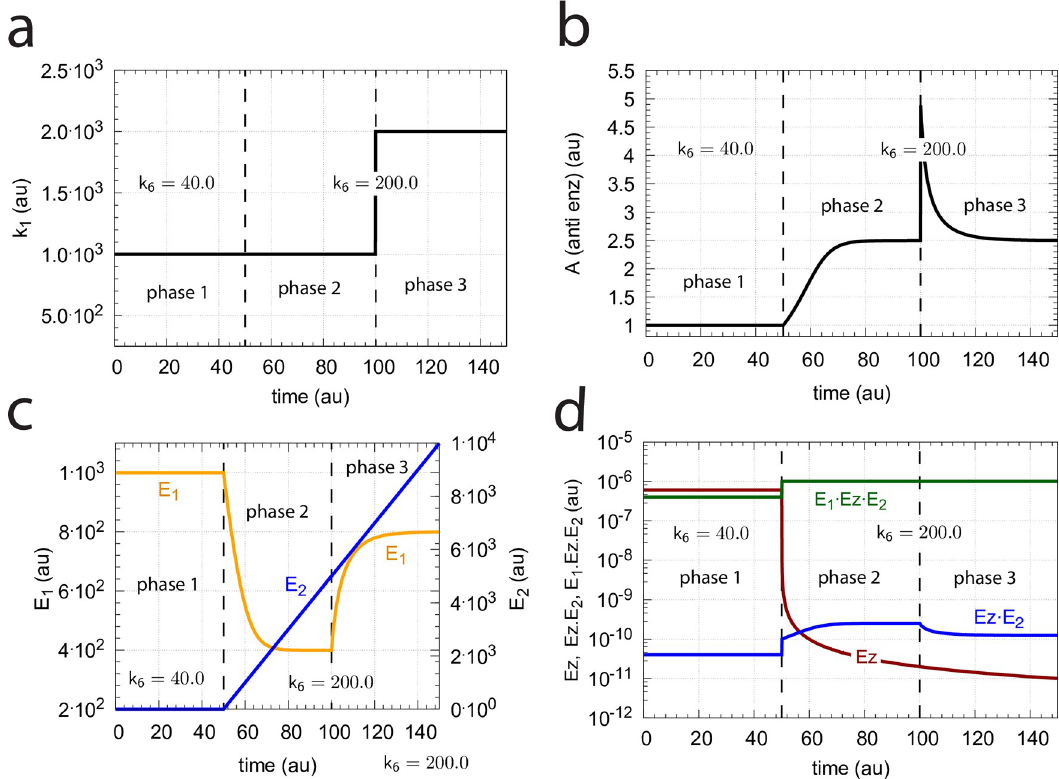
Fig 41. Switch from dual-E to single-E control by increase of k 6 in the compulsory ternary-complex mechanism of motif 5 when E 2 binds first to free Ez (Fig 40). An increase of k 1 in phase 3 shows that the set-point of A under single-E control is defended. (a) Perturbation k 1 as a function of time. (b) Change of the controlled variable A ’s concentration as a function of time. Phase 1: dual-E control; phases 2 and 3: single-E control. (c) Concentration of E 1 and E 2 as a function of time. (d) Concentration of the enzymatic species Ez , Ez � E 2 , and E 1 � Ez � E 2 as a function of time. Rate constants: k 1 =1000.0 (phases 1 and 2), k 1 =2000.0 (phase 3), k 2 =1.0, k 3 =0.0, k 4 =1.0, k 5 =40.0, k 6 =40.0 (phase 1), k 6 =200.0 (phases 2 and 3) k 7 =1 × 10 8 , k 13 = k 15 =1 × 10 9 , k 14 = k 16 =1 × 10 3 . Initial concentrations: